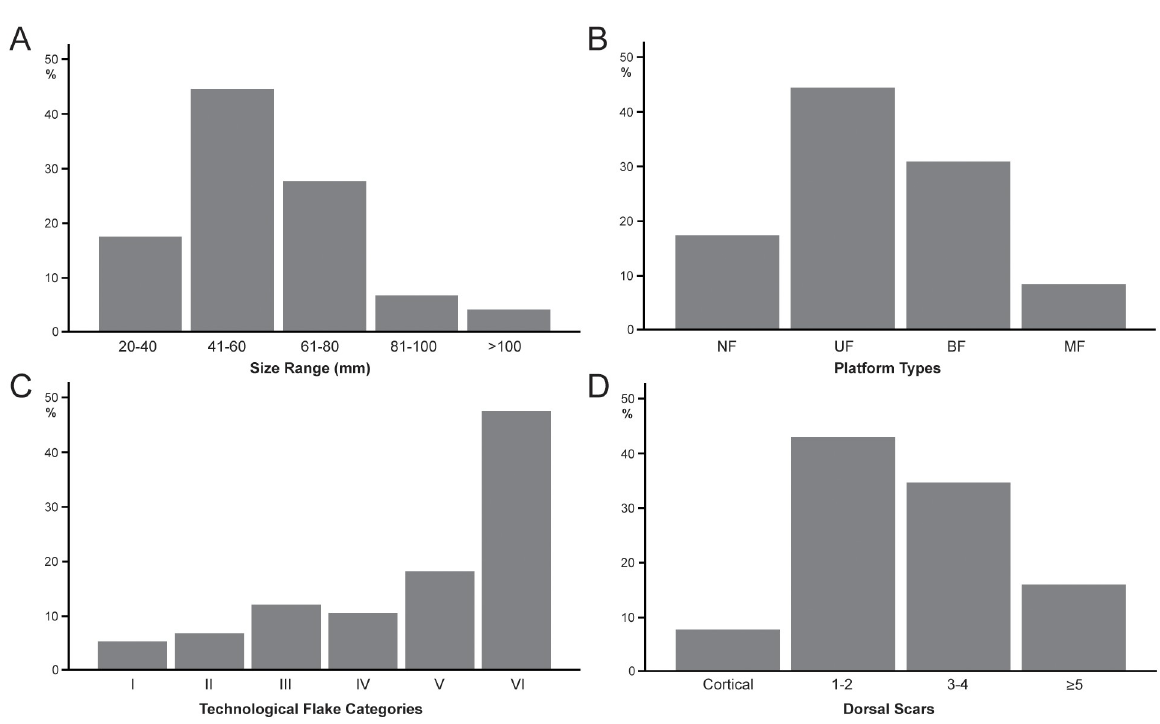
Fig 17. Bar graphs of flake attributes. A) Flake size ranges; B) Platform types; C) Technological flake categories; D) Number of dorsal scars.